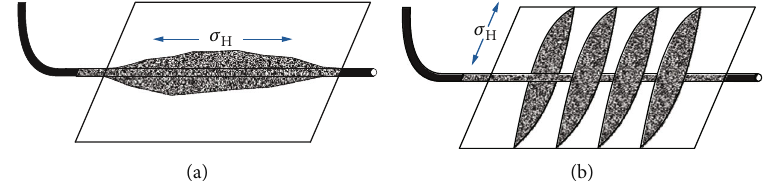
Figure 5: Schematic diagram of fracture orientation under di ff erent layout trajectories of horizontal boreholes: (a) longitudinal crack parallel to horizontal borehole extension; (b) transverse crack perpendicular to horizontal